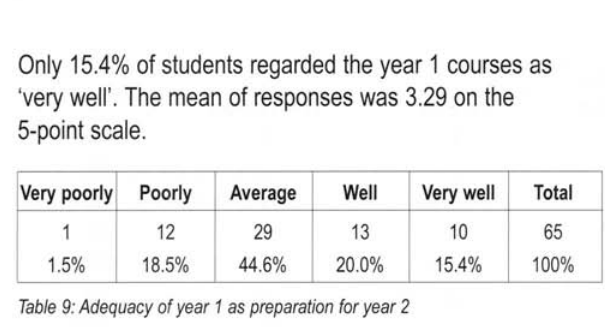
Table 9: Adequacy of year 1 as preparation for year 2 At the PAl the mean of responses was 3.96. Alarge number of students (20.8%) viewed the adequacy of the year 1 academic course as 'average', while even more (37.5%) regarded the course as 'well' and slightly fewer (33.3%) as 'very well'. At the HOI the mean of responses was 2.90. Many students (58.5%) viewed the adequacy of the year 1 academic course as 'average', while fewer (24.4%) regarded the course as 'poorly'.